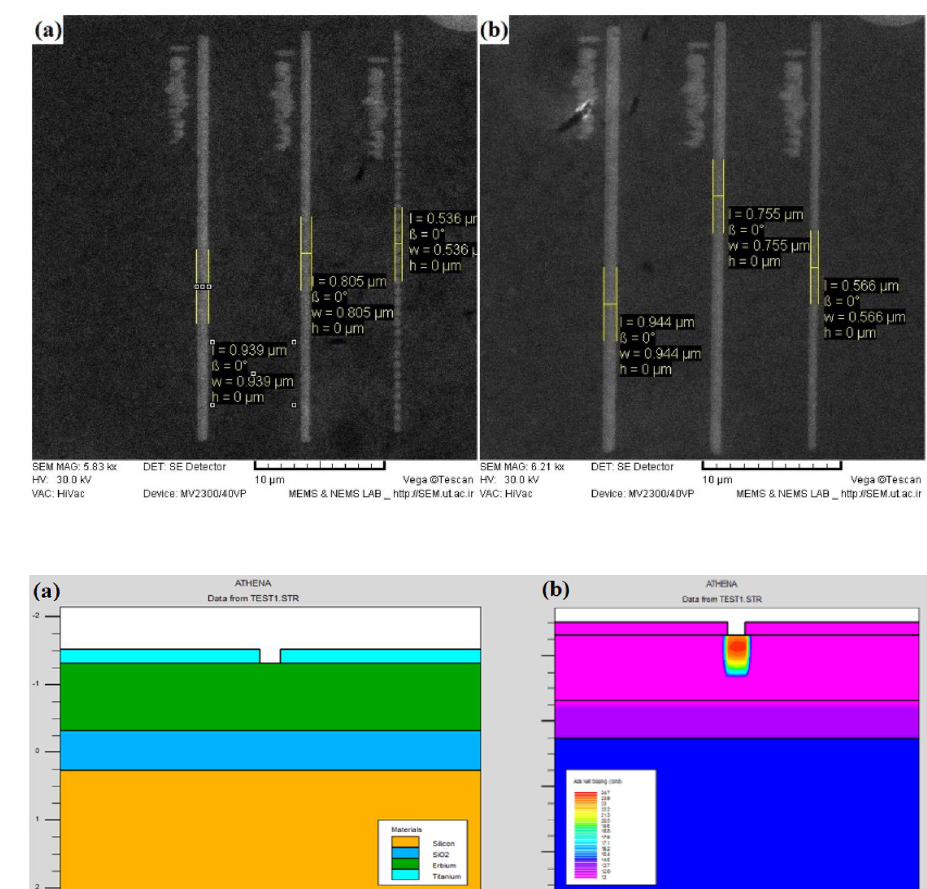
Fig. 6 SEM images of the waveguide in sol–gel Er: Yb doped SiO –Al O coatings 2 2 3 patterned by Electron Beam Lithography: a intermittent waveguide pattern, b continu- ous waveguide pattern